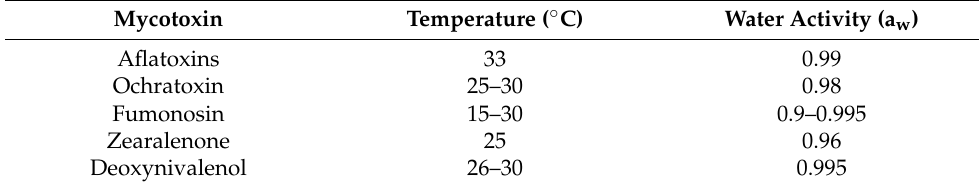
Table 1. Optimum temperatures for mycotoxin production. Adapted from [29].